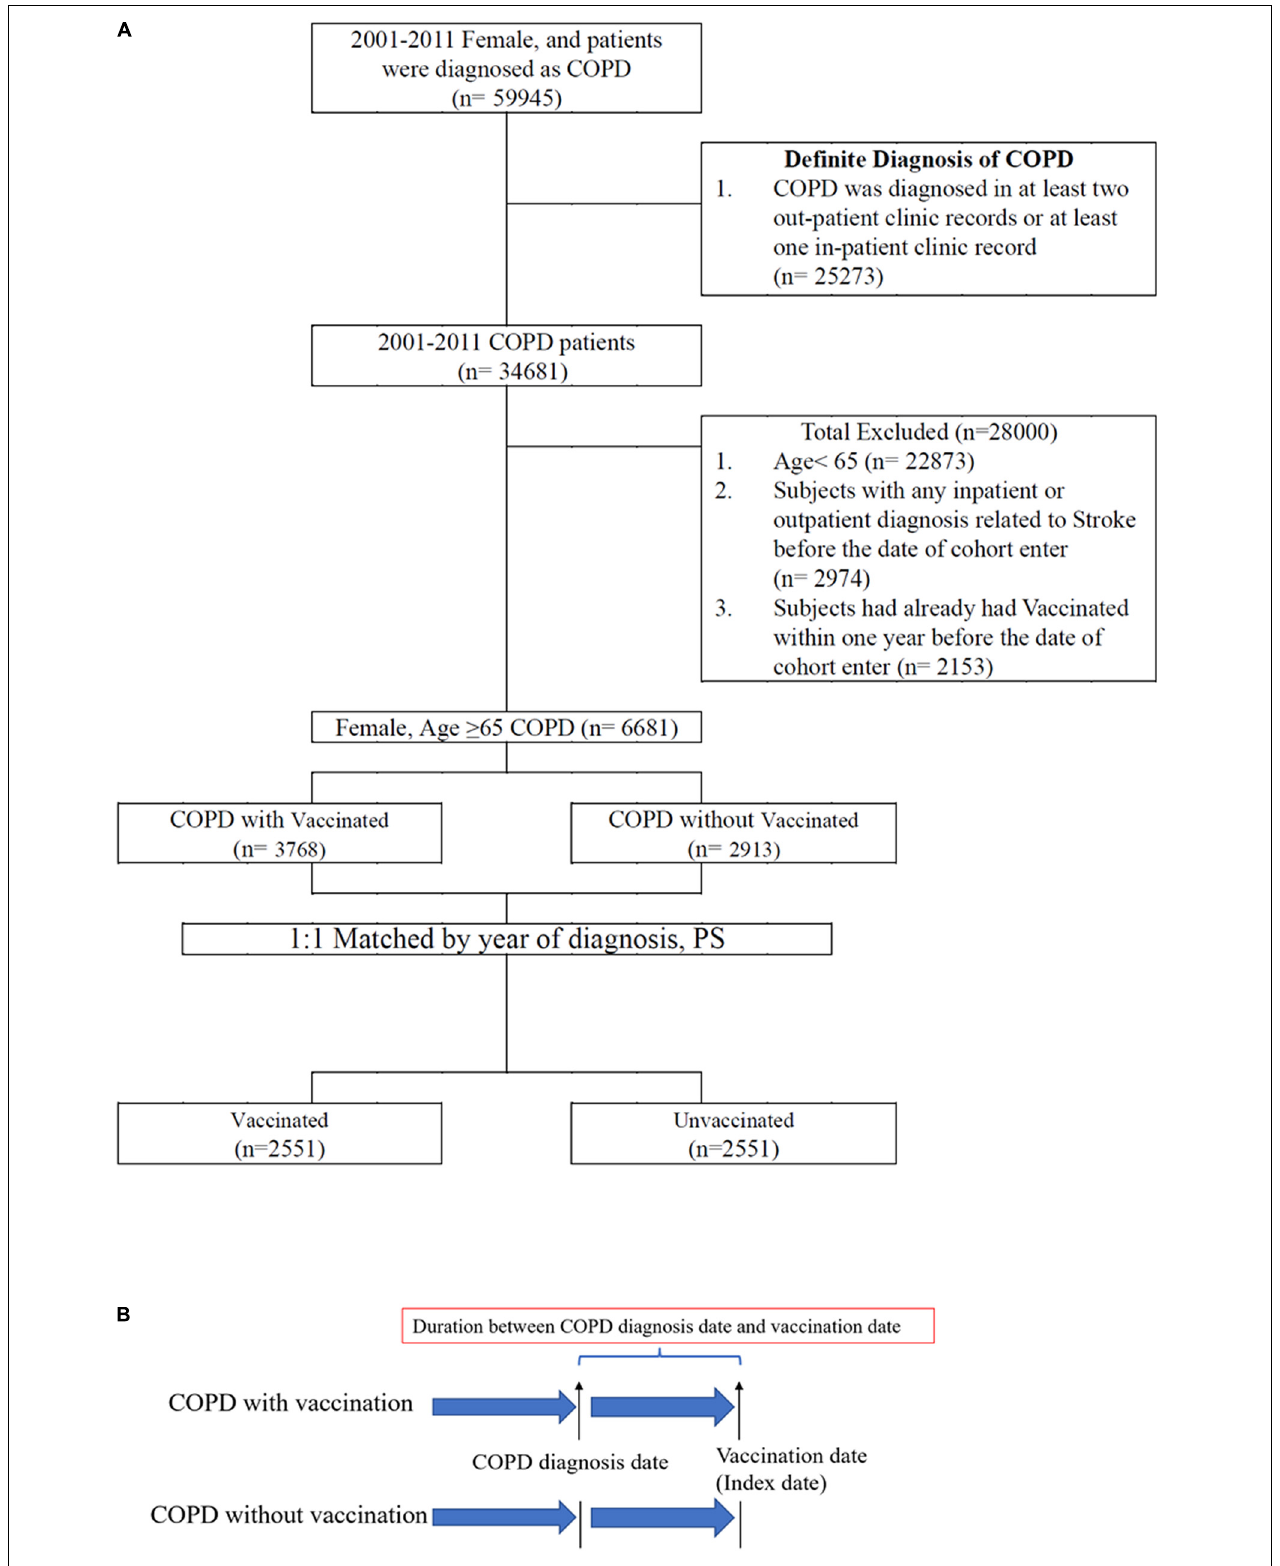
FIGURE 1 | (A) Data selection process. (B) Definition of index date and duration between diagnosis date and vaccination date.